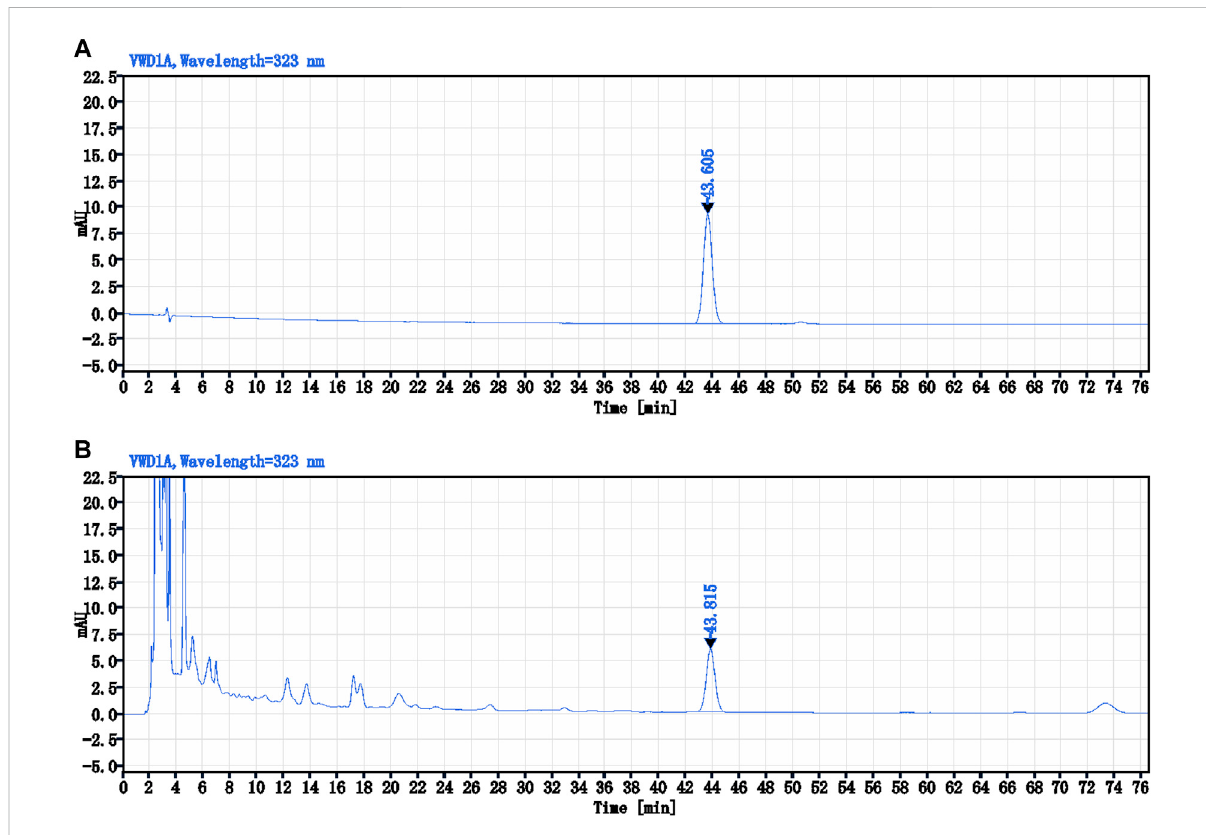
FIGURE 5 The HPLC chromatograms of Ferulic acid and NTF capsules. (A) The control sample (Ferulic acid) solution-10 μ L; (B) The test sample (NTF capsules) solution-10 μ